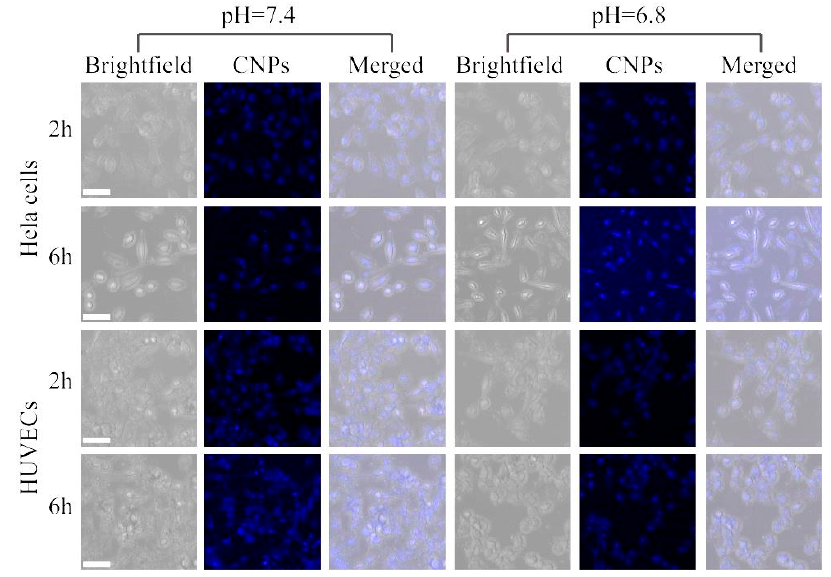
Figure 5. Confocal images of Hela cells and HUVECs after incubation with 10 μ g/mL CNPs for 2 and 6 h at 37 °C . All scale bars are 50 μ m.